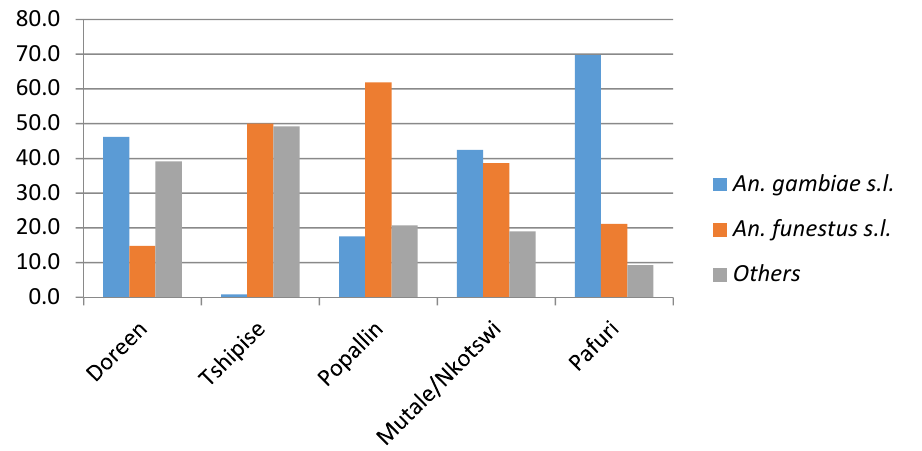
Figure 6. Percentage of Anopheles funestus group and An. gambiae complex collected in Limpopo Province in 2017/18.